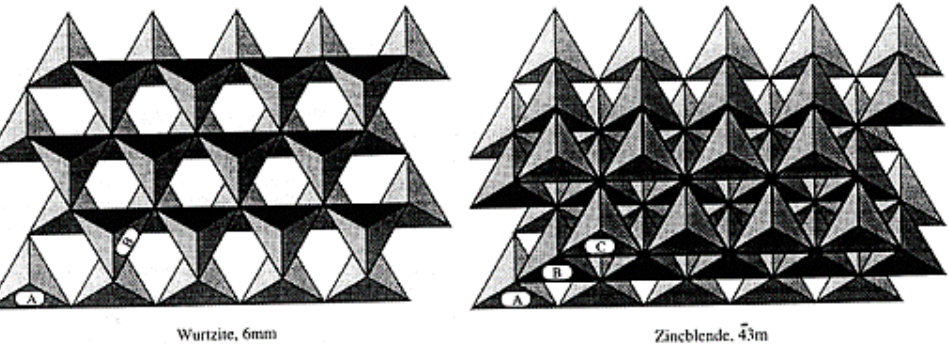
Figure 10. Tetrahedral representation of close-packed planes in cubic and hexagonal SiC. Top schematic shows Zincblende (cubic) structure with CSi4 tetrahedra stacking in ABC periodicity; bottom schematic shows Wurtzite (hexagonal) structure with tetrahedral stacking in AB periodicity. Reprinted with permission from Reference [27]. Copyright 1996 The American Ceramic Society/Wiley.